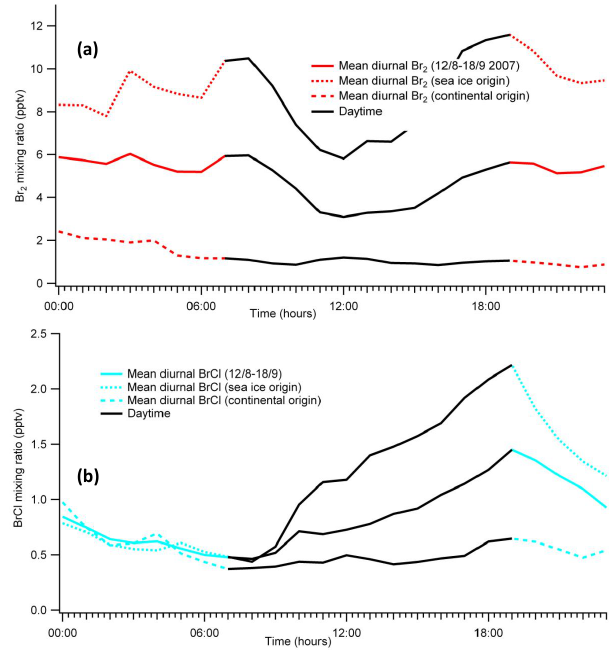
Fig. 7. Hourly mean diurnal plots of (a) Br 2 , and (b) BrCl for all the data, and for different source regions (sea-ice zone;